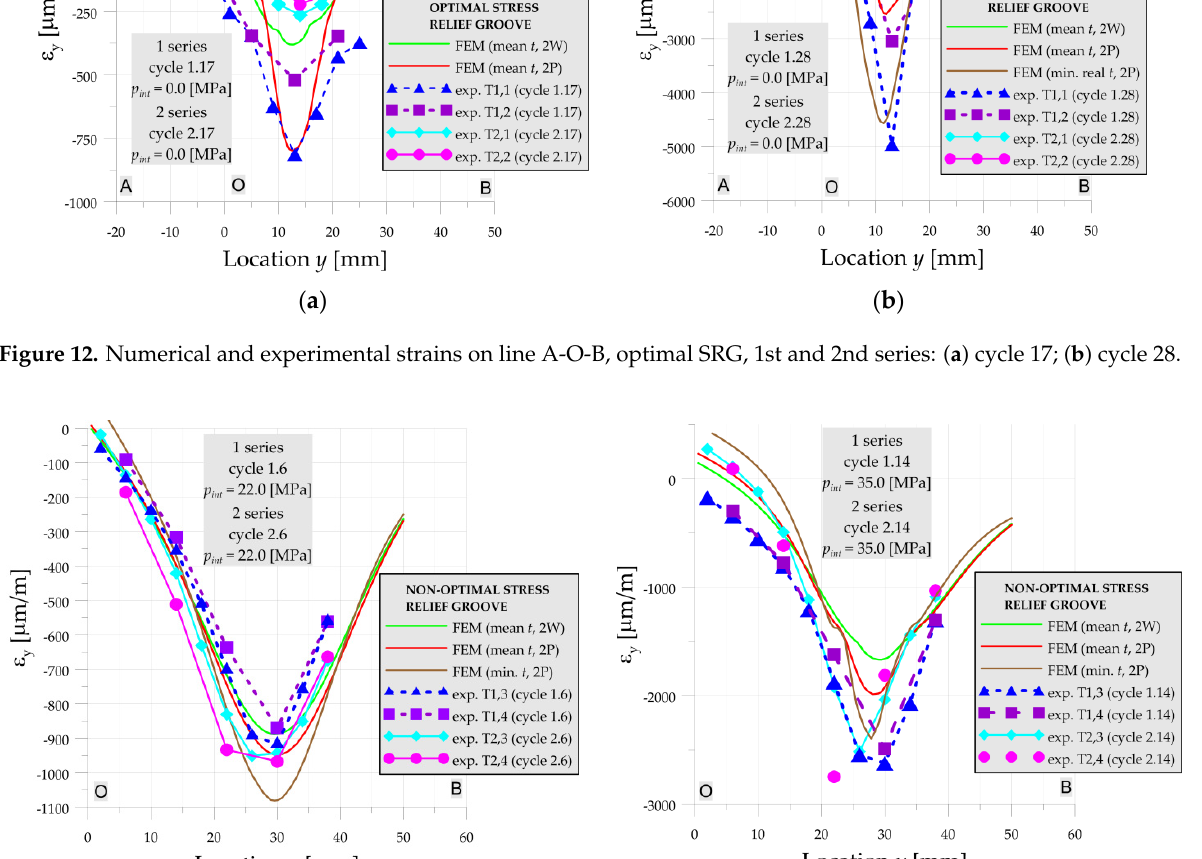
Figure 12. Numerical and experimental strains on line A-O-B, optimal SRG, 1st and 2nd series: ( a ) cycle 17; ( b ) cycle 28.